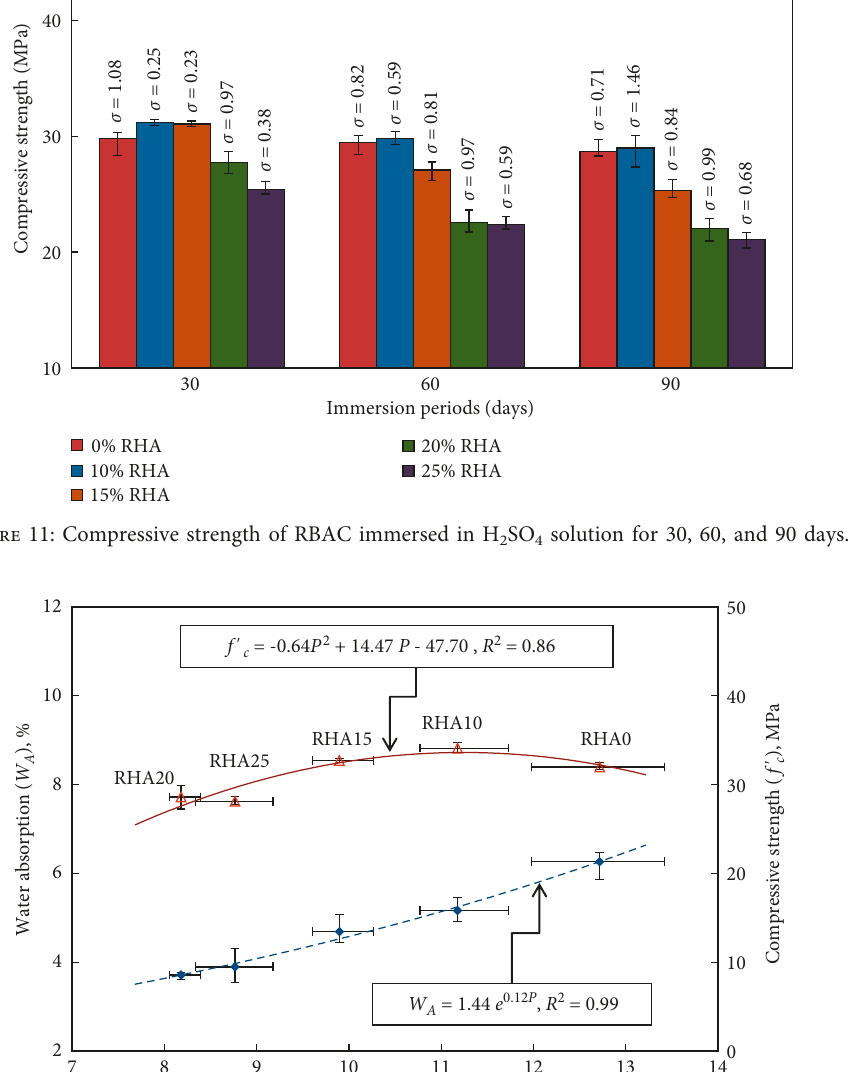
Figure 12: Relationship among the porosity, water absorption, and compressive strength of RBAC after 90 days of curing.